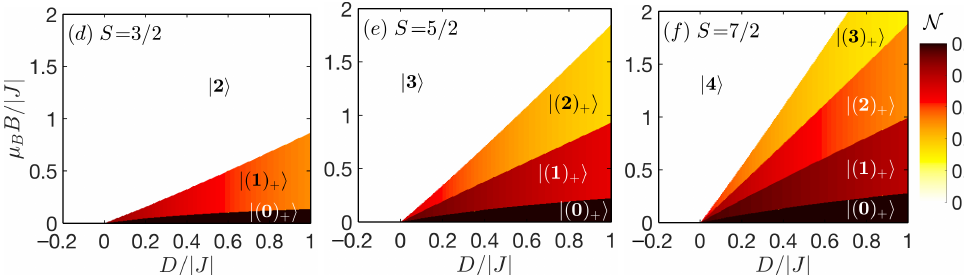
Figure 2. Density plots of a quantum negativity in the D / | J | − µ B B / | J | plane for the spin-(1/2, S ) Heisenberg dimers with the ferromagnetic coupling constant J < 0 for an integer (upper panels: ( a ) S = 1, ( b ) S = 2, ( c ) S = 3) and half-odd-integer (lower panels: ( d ) S = 3/2, ( e ) S = 5/2, ( f ) S = 7/2) and isotropic interaction ( ∆ = 1).